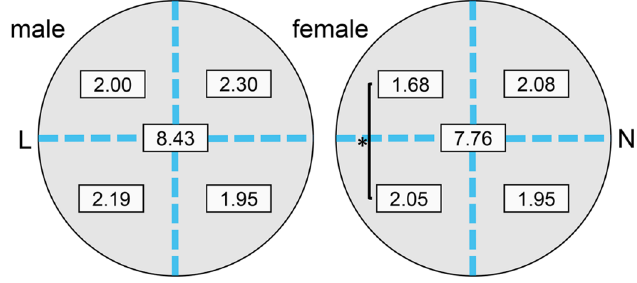
Figure 2. Distribution of vortex vein ampullae by sex. In men, the mean number of vortex vein ampullae (VVA) was 8.43/eye and 2.00, 2.19, 2.30 and 1.95 in the upper lateral (UL), lower lateral (LL), upper nasal (UN), and lower nasal sector (LN), respectively. In the women, the mean number of VVA was 7.76/eye and 1.68, 2.05, 2.08, and 1.95 in the upper lateral, lower lateral, upper nasal, and lower nasal sectors, respectively. A statistically significant difference was observed between UL and LN sectors in the women (* P = 0.043, Wilcoxon signed rank sum test) L lateral side, N nasal